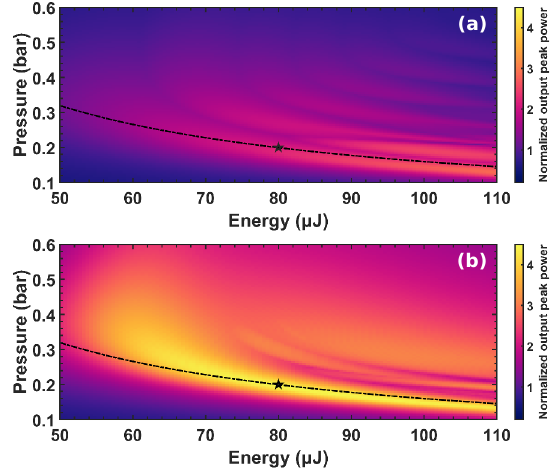
Figure 1. Peak power of the self-compressed pulses normalized to its initial value as a function of input pulse energy and equiv- alent gas pressure for (a) a statically argon-filled HCF and (b) its equivalent di ff erentially pumped fiber with a decreasing pressure gradient. The dot-dashed line represents the curve of constant B-integral ( B = 8 . 5 rad) which best fits the optimal region for high-quality self-compression and the star refers to the final situ- ation shown in Fig. 2 (80 µ J, 200